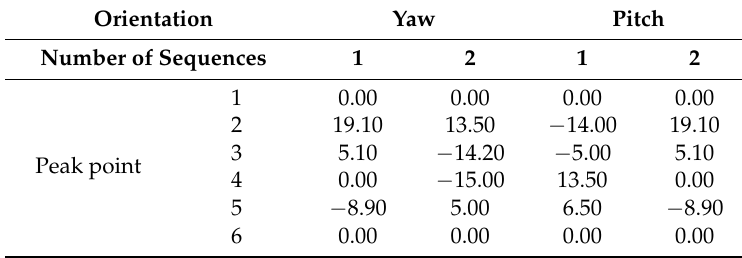
Table 1. Peak points of simulated head orientations in yaw and pitch directions.